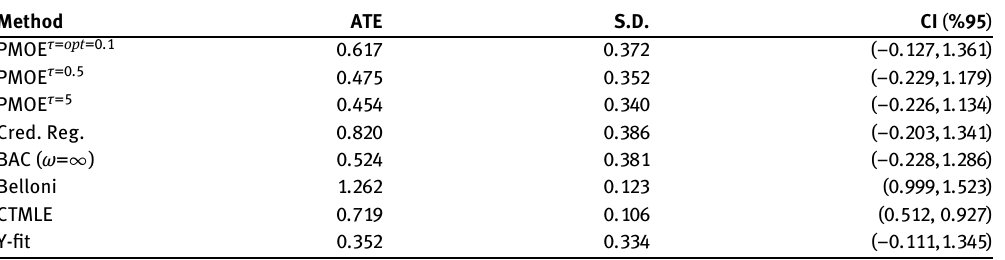
Table 4: The economic growth